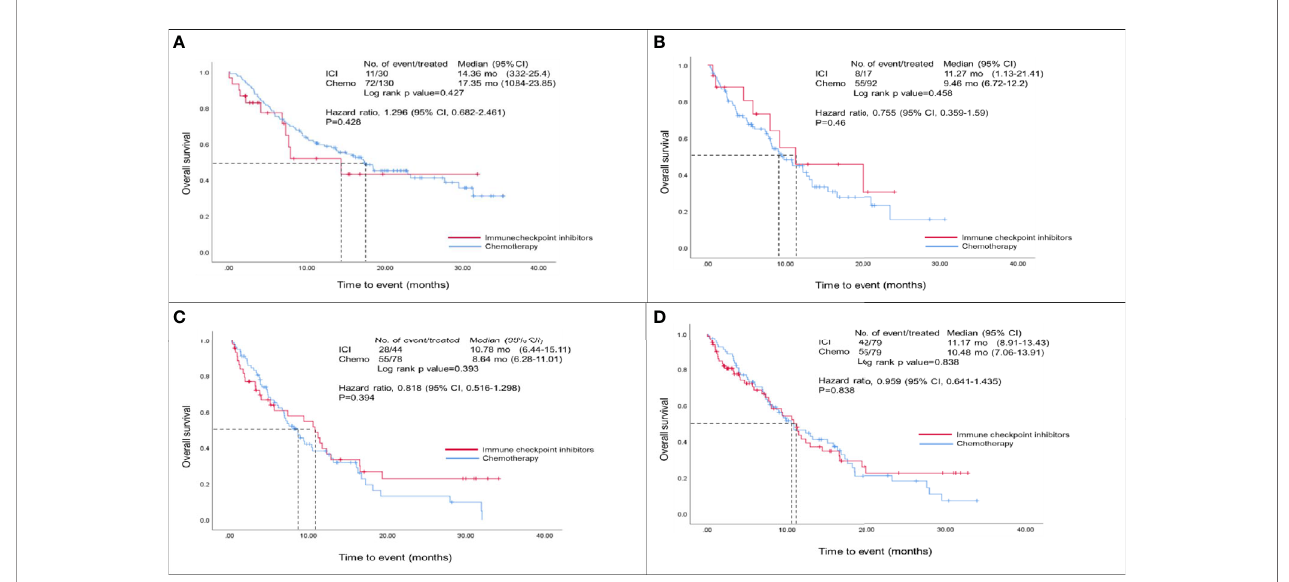
FIGURE 2 | Overall survival analysis of ICIs and Chemo groups. (A) Overall survival analysis of the fi rst-line group before matching; (B) Overall survival analysis of the second-line group before matching; (C) Overall survival analysis of those patients at third-line and over before matching; (D) Overall survival analysis of both ICIs and Chemo groups after matching; Hazard ratios were adjusted for histological types, tumor stage, brain metastasis, and PD-L1 expression variables in the cox- regression model.